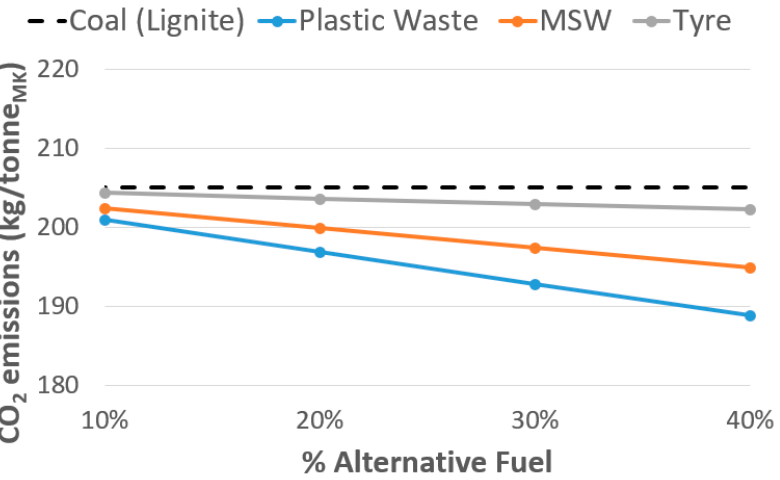
Figure 9. Calculated CO 2 emissions (kg/tonne MK ) by substituting coal (lignite) with alternative fuels. (C-EGR scenario/Reference Kiln Temperature: 750 °C/Reference moisture content: 15%wt).